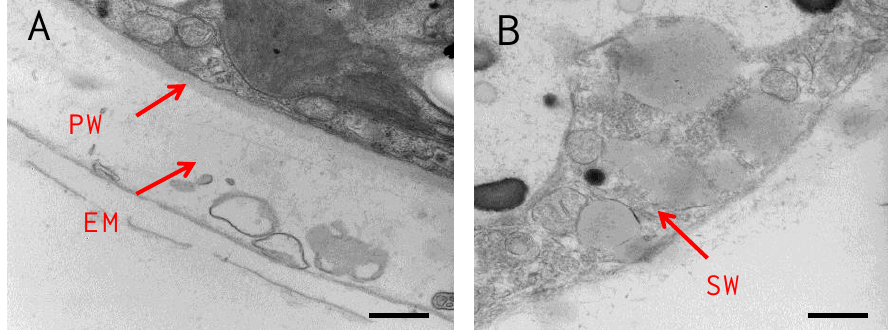
Figure 2. The morphology of cell wall of H. pluvialis in the aplanospore stage under the stress of SAHL. ( A ) The cell wall of H. pluvialis under the normal condition for 48 h as control. ( B ) The cell wall of H. pluvialis in SAHL_48 stage. PW and EM represent primary wall and extracellular matrix, SW in picture B is the secondary wall. Bars represent 500 nm.